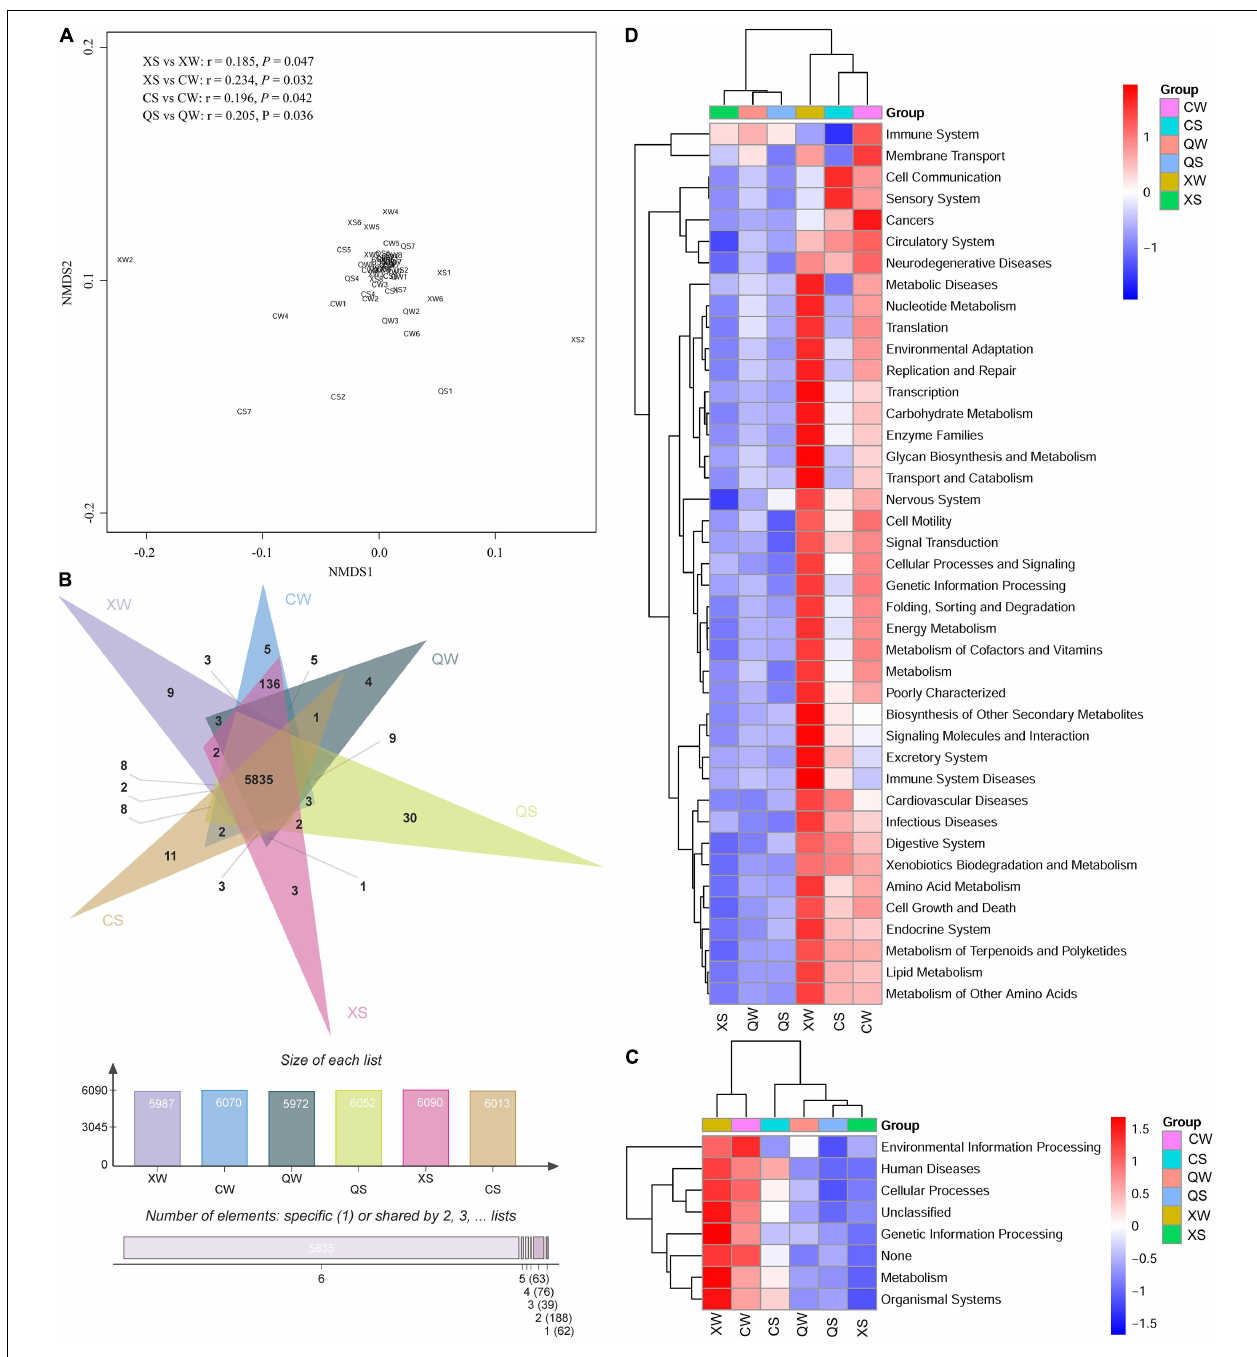
FIGURE 7 | Non-metric multi-dimensional scaling analysis of the functional pathways in the six groups of Nibea albiflora male, female, and all-female fish during an investigation of the composition of their intestinal microbiota, based on Bray-Curtis distance (A) . Venn diagram of shared and unique functions among the six groups (B) . Heatmap showing the compositions of the functional pathways at the class-1 (C) and 2 (D) levels. X, C, and Q represented male, female, and all-female fish, respectively. Two seasons: summer (S) and winter (W).